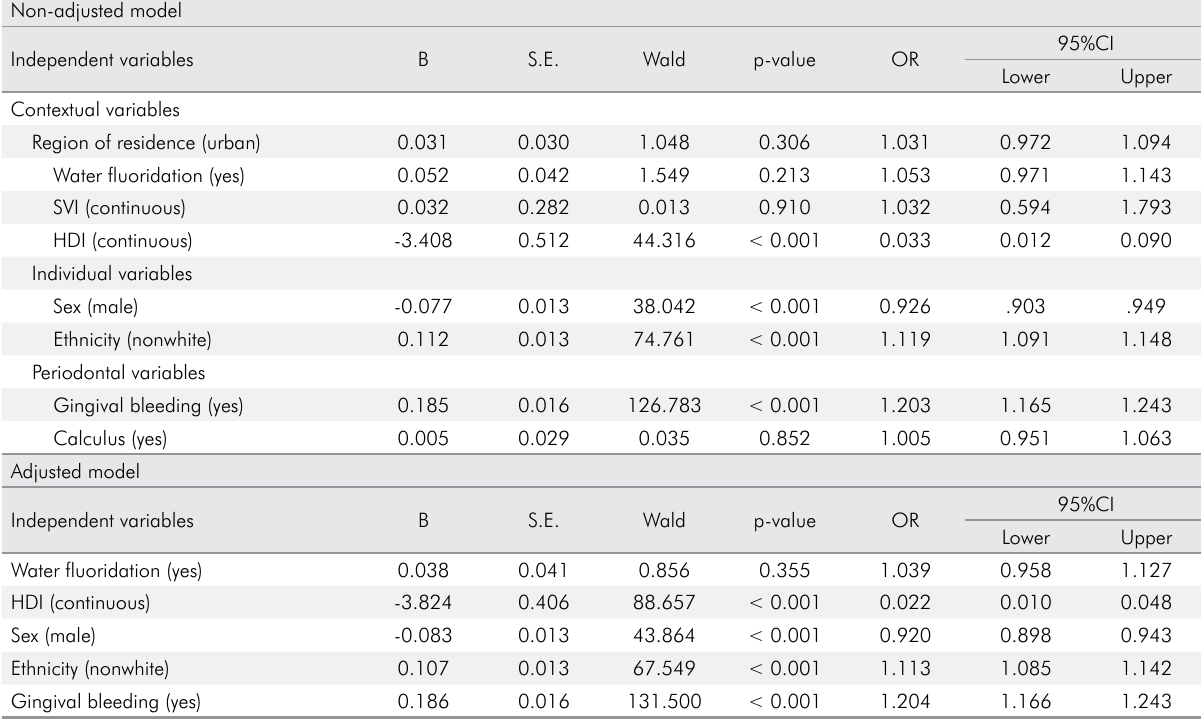
Table 2. Non-adjusted and adjusted multivariate logistic regression model that assessed factors associated with the dental caries experience of 12-year-old children (n =